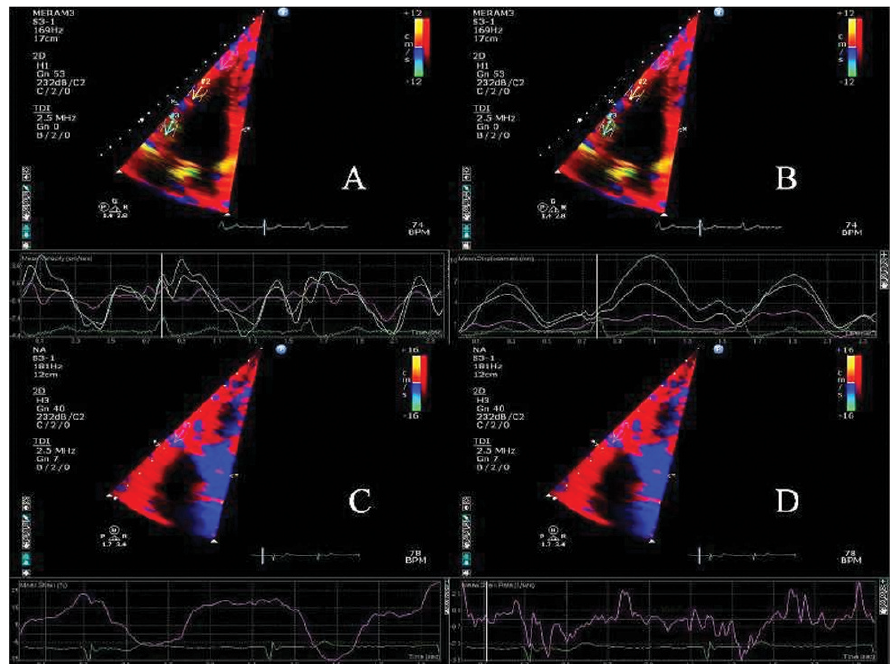
Figure 1 - A) Myocardial velocities associated with the basal, mid, and apical segments of the right ventricle. B) Myocardial deformation curves associated with the basal, mid, and apical segments of the right ventricle. C) Strain curve of the mid segment of the right ventricle. D) Strain rate curve of the mid segment of the right ventricle.